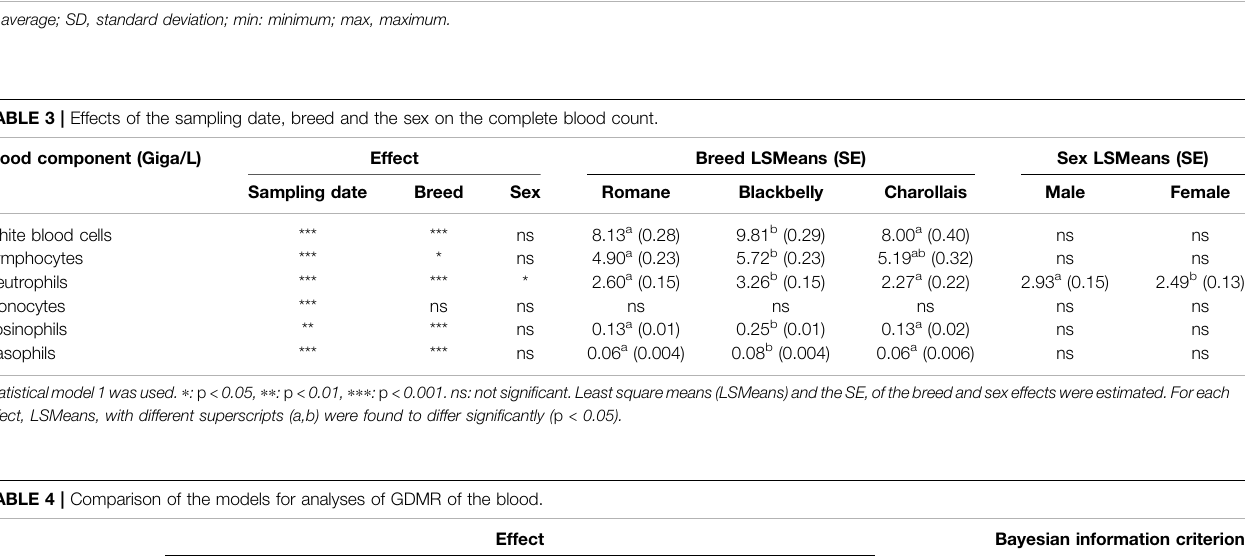
TABLE 4 | Comparison of the models for analyses of GDMR of the